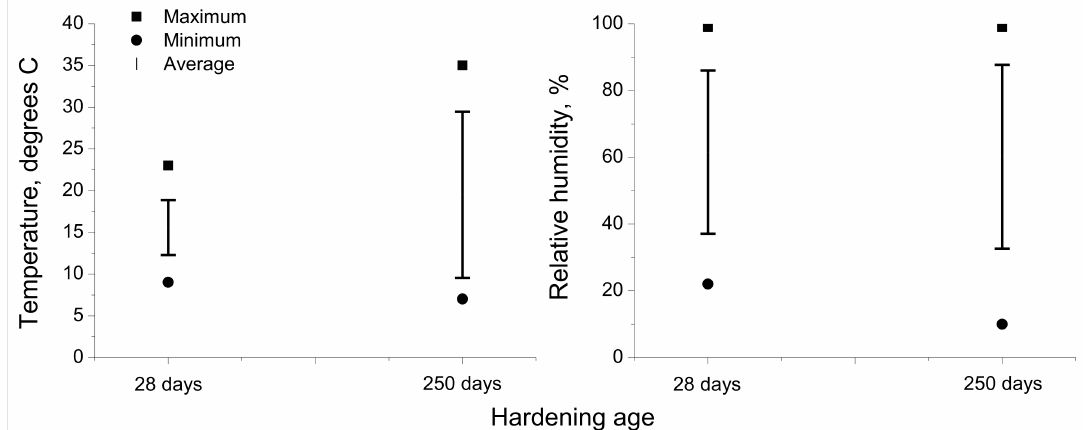
Figure 4. Absolute maximum, absolute minimum, and variation interval of the average daily temperature and relative humidity at which the samples tested at 28 and 250 days were exposed.